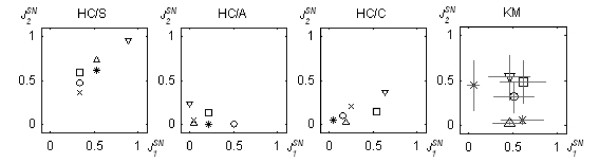
CNS dataset: stability-normalized pairwise Jaccard indices of cluster labels assigned by the various methods. Clusterings into k = 5 clusters obtained using correlation distance on 1000 probe sets. Legend is shown in Figure 3D. For k-means, the grey bars indicate standard deviation over 10 repeated experiments.